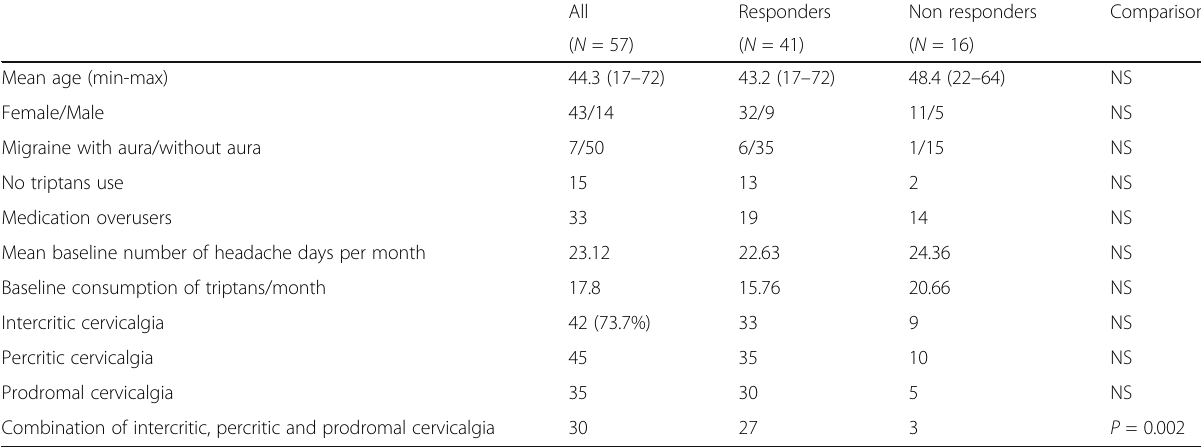
Table 3 Description of the population and comparison of data in responders vs non